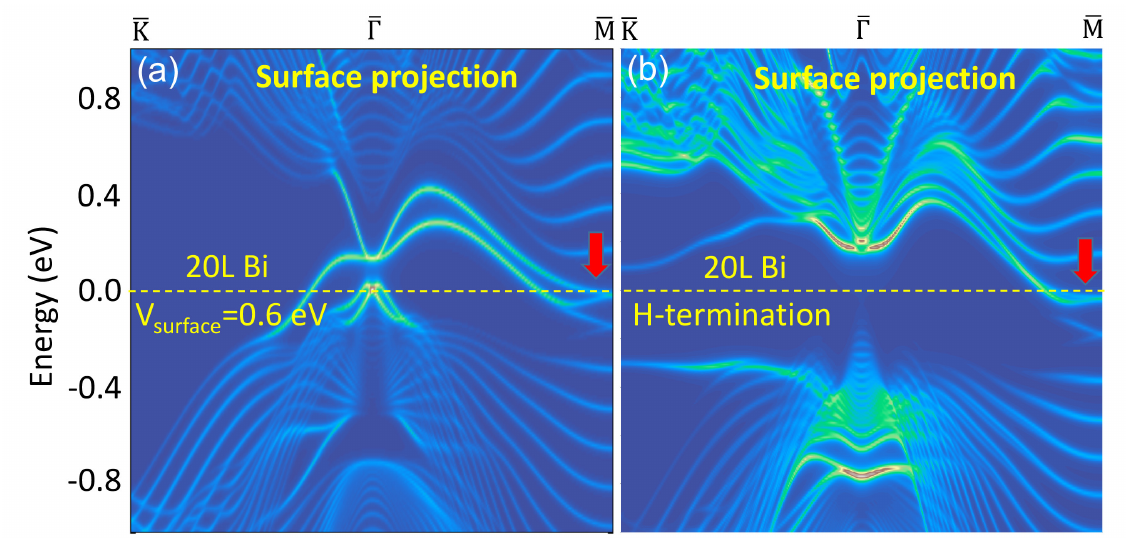
Figure 6. (Color online). ( a ) Top-surface band spectrum of 20L Bi(111) with a surface potential 0.6 eV on the top layer. ( b ) Top-surface band spectrum of 20L Bi(111) with top surface terminated with H atoms. In both cases, the surface perturbation removes the degeneracy of the top and bottom surface states and thus kills the tunneling energy gap due to the hybridization effects. The perturbed surface band dispersion shows two Dirac cones at Γ and M and thus demonstrates the trivial bulk band topology of